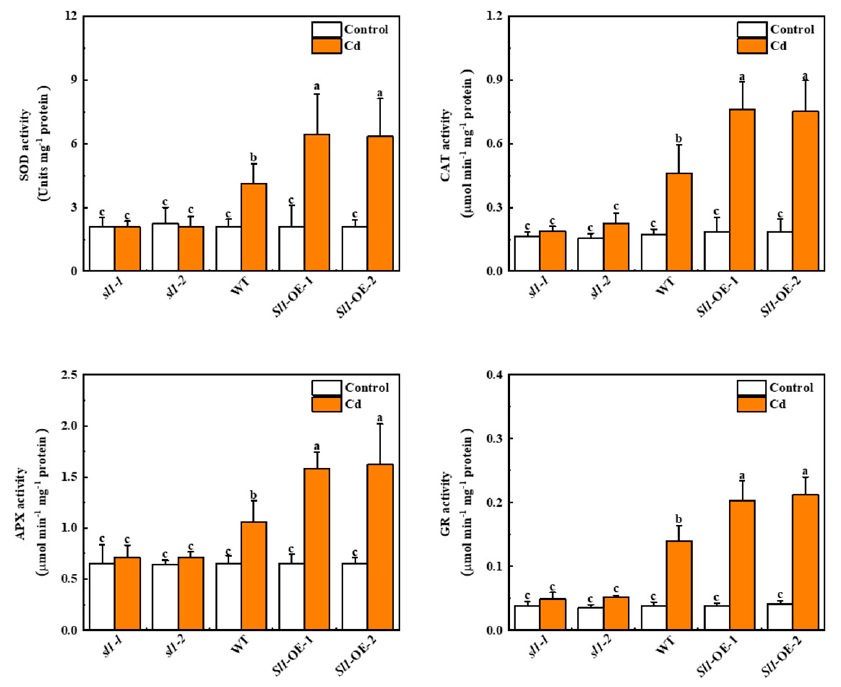
Figure 4. Sl1 promotes antioxidant enzyme activities in tomato plants under Cd stress. The activities of SOD, CAT, APX, and GR in the roots of Sl1 mutant lines ( sl1-1/2 ), wild-type (WT), and Sl1 overexpressing lines ( Sl1 -OE-1/2) under Cd stress for 3 d. The data presented here are the average of three biological replicates (±SD). Different letters indicate a significant difference ( p < 0.05, Tukey’s test).